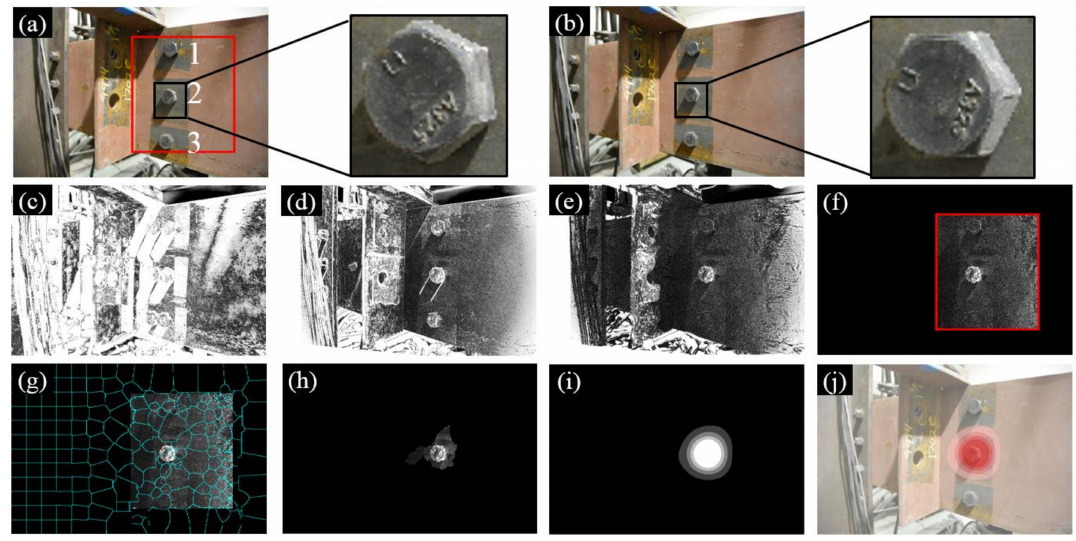
Figure 10. Experimental results of Test 3: ( a ) Image 1 taken at the first inspection period; ( b ) Image 2 taken at the second inspection period; ( c ) initial errors between Image 1 and 2; ( d ) errors after feature-based image registration; ( e ) errors after intensity-based image registration; ( f ) windowing applied to the registration errors; ( g ) registration errors segmented into superpixels; ( h ) feature enhancement; ( i ) Gaussian filtering; and ( j ) result implementation. The brightness of Figure 10c–h is enhanced for demonstration